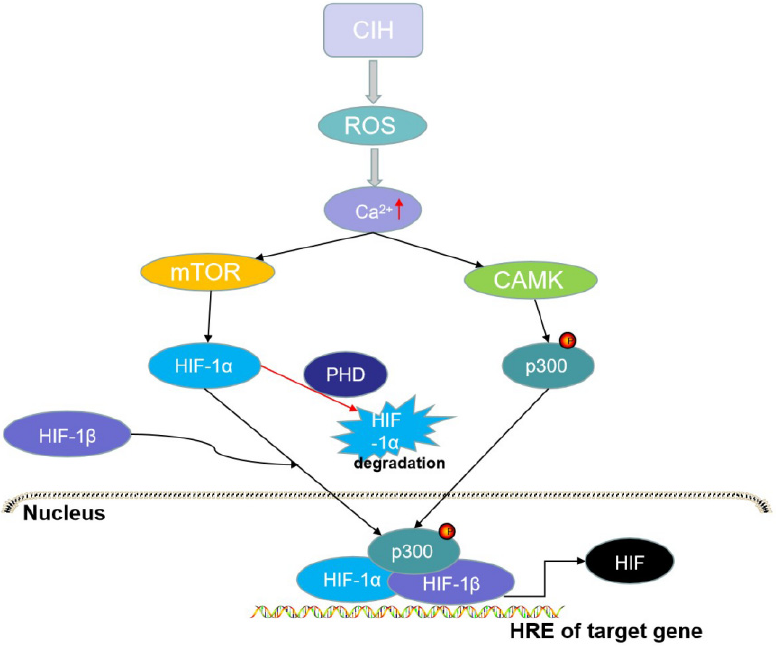
Figure 3. The activation of hypoxia-inducible factor (HIF)-1 α . CIH can evoke oxidative stress and reactive oxygen species (ROS), while ROS can activate the Ca 2+ -dependent calpain proteases (CAMK) that can directly phosphorylate p300, and activate the mammalian target of rapamycin (mTOR) that promotes the expression of HIF-1 α protein. The HIF-1 α /HIF-1 β /p300 complex in the nucleus can promote the transcription of HIF-1 genes. However, oxygen can induce the degradation of HIF-1 α through prolyl hydroxylases (PHDs).